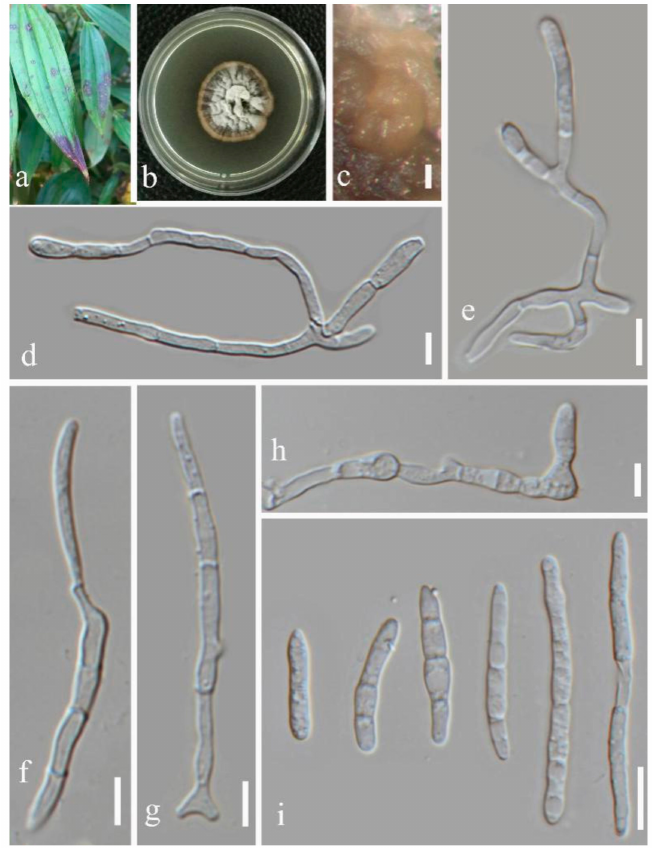
Figure 6. Septoria dispori (GUCC 2127.1) ( a ) Leaf spot symptoms on the host. ( b ) Colony on PDA. ( c ) Conidiomata on PDA culture. ( d , e ) Conidiophores. ( f – h ) Conidiogenous cells and conidia. ( i ) Conidia. Scale bars: ( c ) = 20 µ m, ( d ) = 10 µ m ( e ) = 5 µ m, ( f – i ) = 10 µ